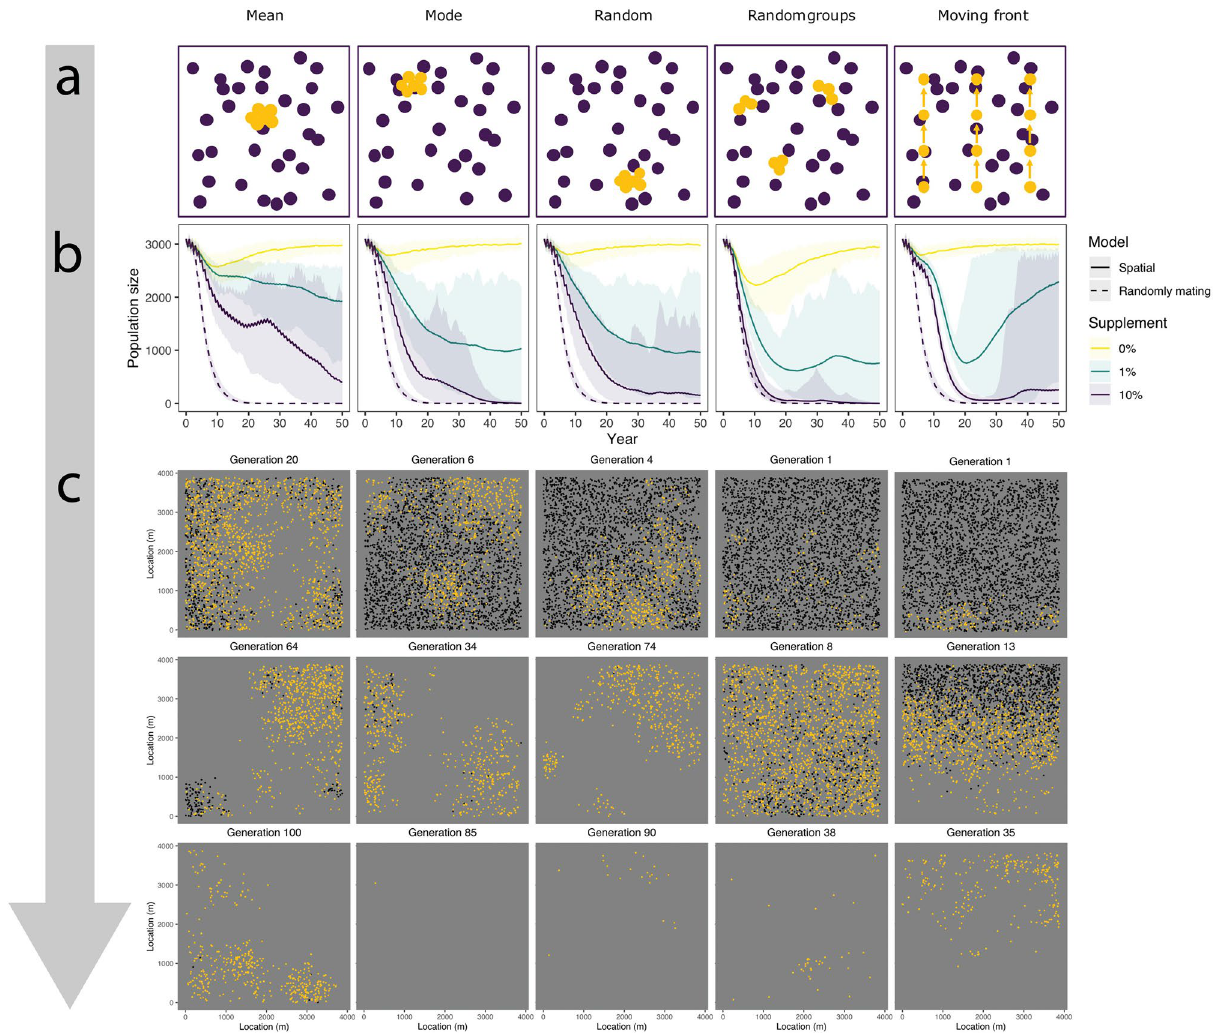
Figure 6. Spatial dynamics of HD-ClvR using different placement schemes. ( a ) A schematic overview of the placement schemes. ( b ) Population size as a function of the placement schemes and amounts of supplementation. We modelled population size over time after the introduction of 100 squirrels with a HD-ClvR gene drive with 1 homing gRNA and 4 cleave-and-rescue gRNAs to a population of carrying capacity 3000. We modelled an NHEJ rate ( P n ) of 0.02 and a daisyfield of size 30. ( c ) Three snapshots of moments representing key spatial dynamics at 10% supplementation. See the full animations in Supplementary Videos